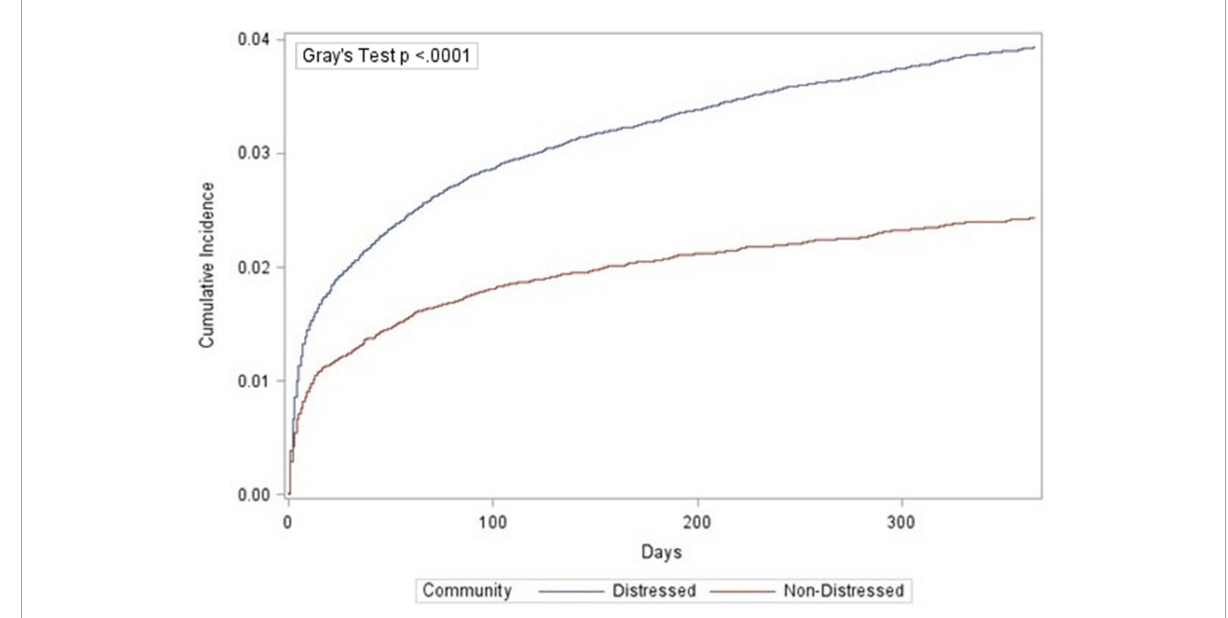
FIGURE1 Cumulative incidence function of amputations by community distress